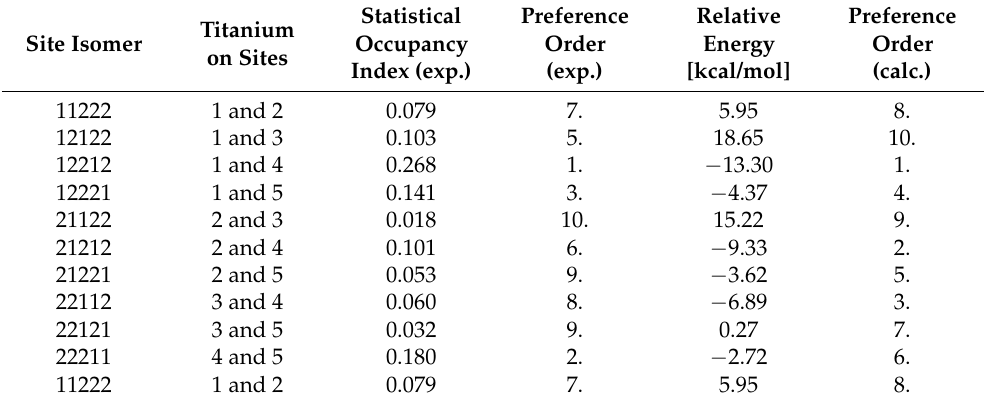
Table 4. Experimental (based on Ti site occupancies) and calculated (based on energy) site preference orders of the ten LNT isomers. The statistical occupancy index is calculated as the product of the Ti occupancies of the two respective sites. The relative energies refer to the calculations listed in the first row of Table